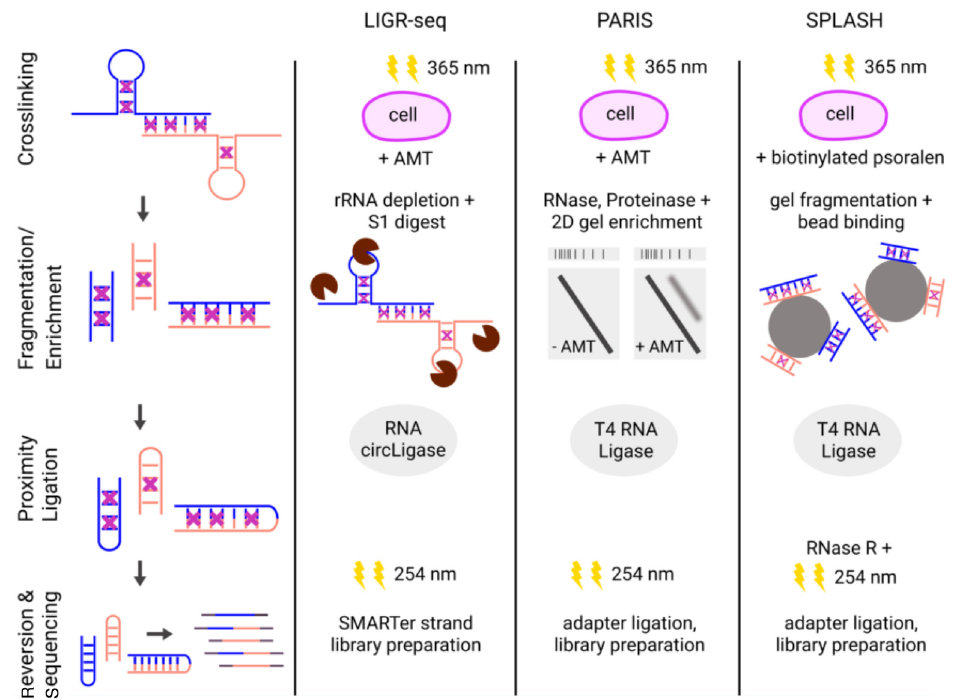
Figure 1. Schematic comparison of Direct Duplex Detection methods. Overview of the protocols for LIGR-seq 21 , PARIS 22 , and SPLASH 23 . The first column shows the principal steps of the three experimental procedures: crosslinking (violet crosses) was conducted in vivo by 365 nm irradiation and 4 ′ -aminomethyltrioxsalen (AMT) or biotinylated psoralen treatment. Fragmentation was performed enzymatically (LIGR-seq and PARIS) or chemically (SPLASH). Crosslinked RNAs were additionally enriched either by size separation using two-dimensional (2D) gel electrophoresis (crosslinked RNAs above the main diagonal were eluted; PARIS) or by biotin-streptavidin binding to magnetic beads (SPLASH). Proximity ligation was carried out using different ligases. Crosslinks were reverted by 254 nm irradiation. For sequencing, different library preparation strategies were performed. Colors of RNA strands (blue and orange) indicate different RNA molecules. LIGR-seq, ligation of interacting RNA followed by high-throughput sequencing; PARIS, psoralen analysis of RNA interactions and structures; SPLASH, sequencing of psoralen-crosslinked, ligated, and selected